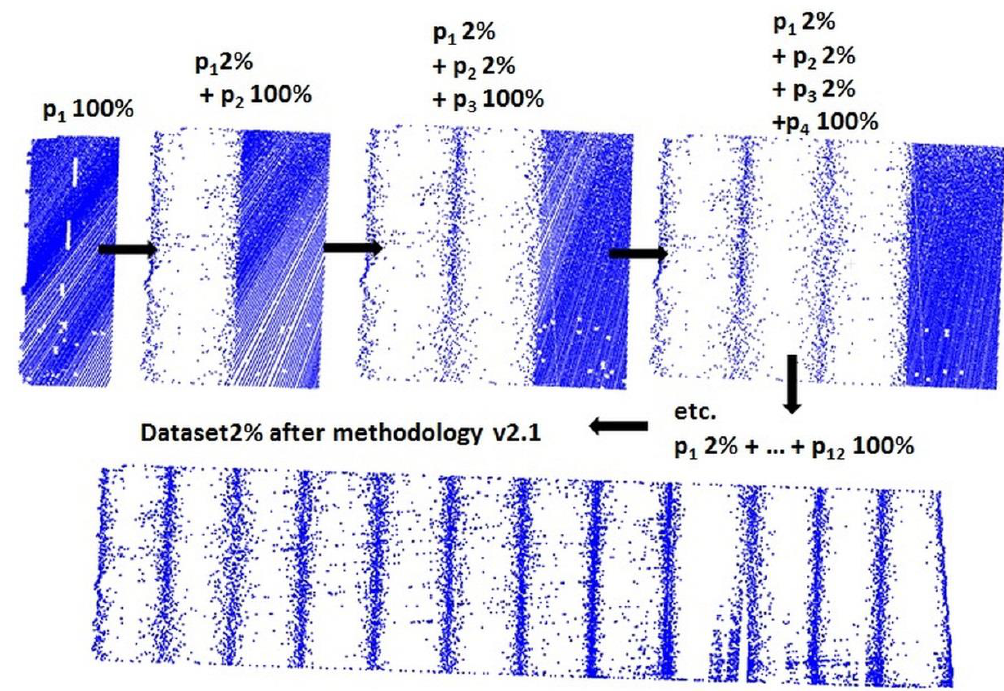
Remote Sens. 2019 , 11 , x FOR PEER REVIEW Figure 6. Scheme of the test area division into strips without overlay (methodology v2.1).